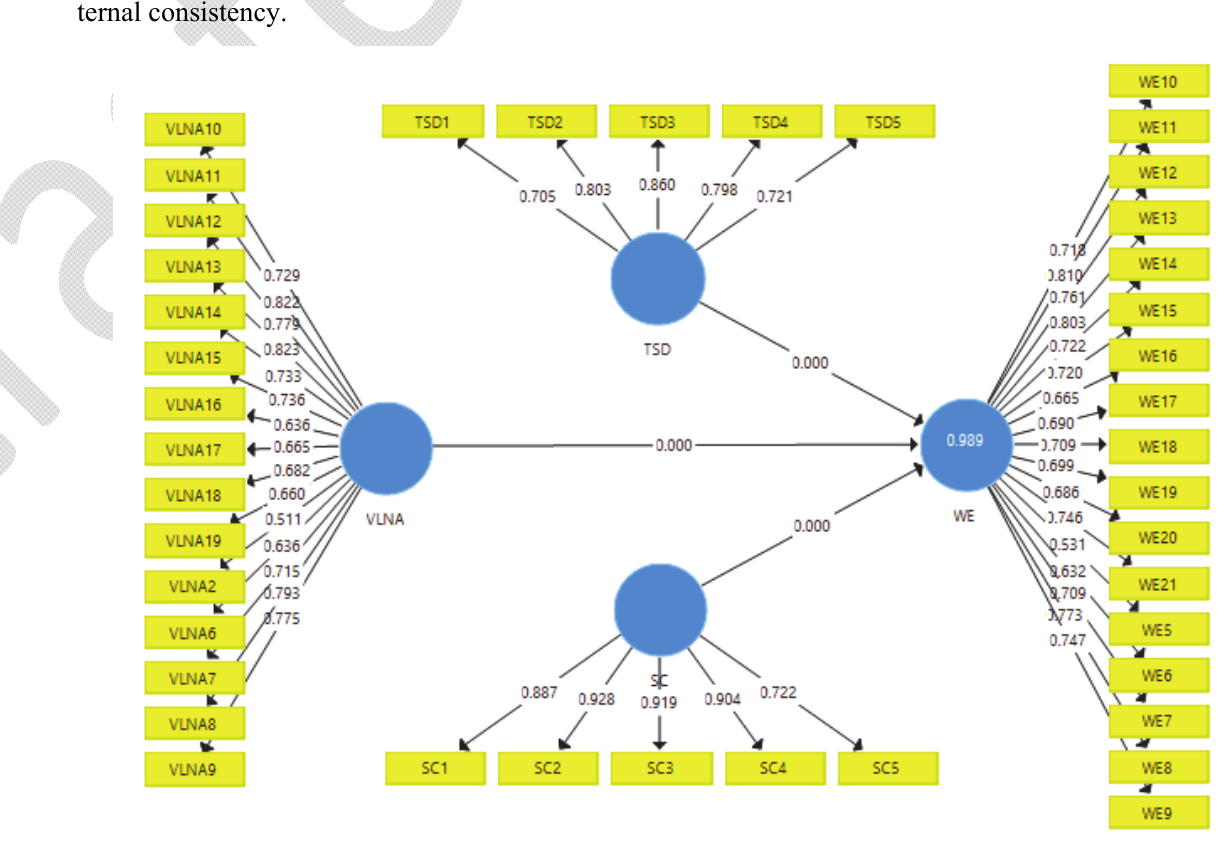
Fig. 2. Measurement Model